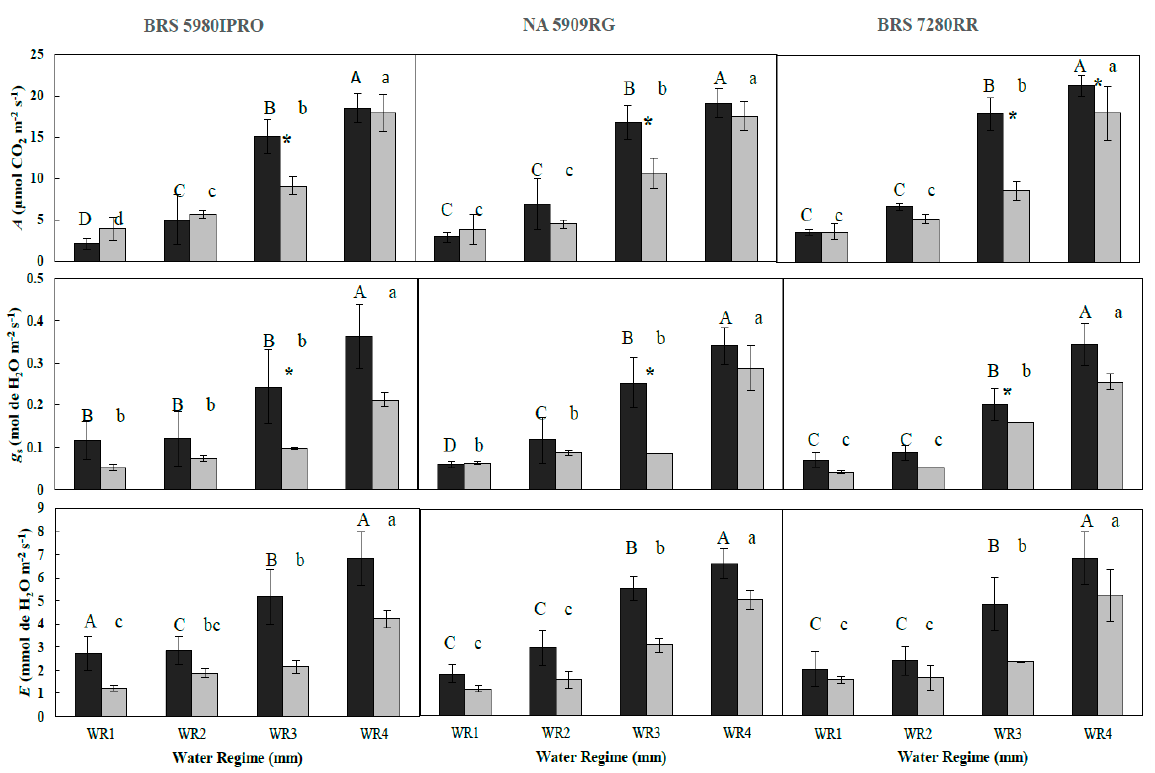
Figure 3. Photosynthesis, ( A ), stomatal conductance ( g s ) and transpiration ( E ) in three soybean cul- tivars submitted to four water regimes (WR) for three cultivars (BRS 5980IPRO, NA 5909RG and BRS 7280RR) with and without polymer supply (WR1 157 mm, WR2 263 mm, WR3 432 mm and WR4 630 mm) in 2016. Uppercase letters indicate differences between the WR for control (without polymer) and lowercase letters indicate differences between the WR for polymer treatment and “*” indicates significant differences between the treatments with and without polymer supply by Tukey’s test ( p <